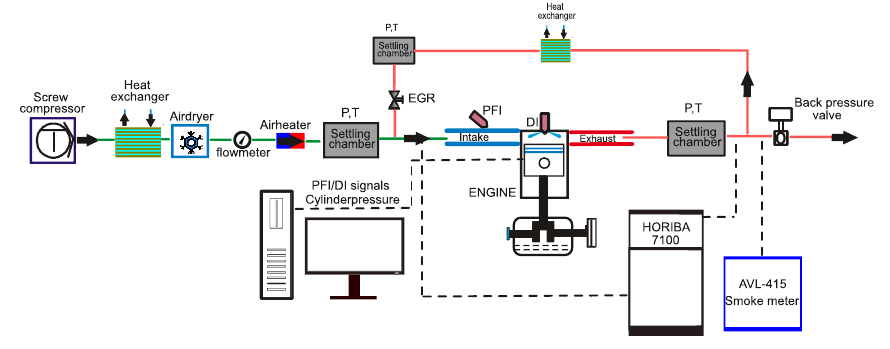
Figure 2. Test cell scheme [43]. EGR: exhaust gas recirculation. Table 4. Accuracy of the instrumentation used in this work.